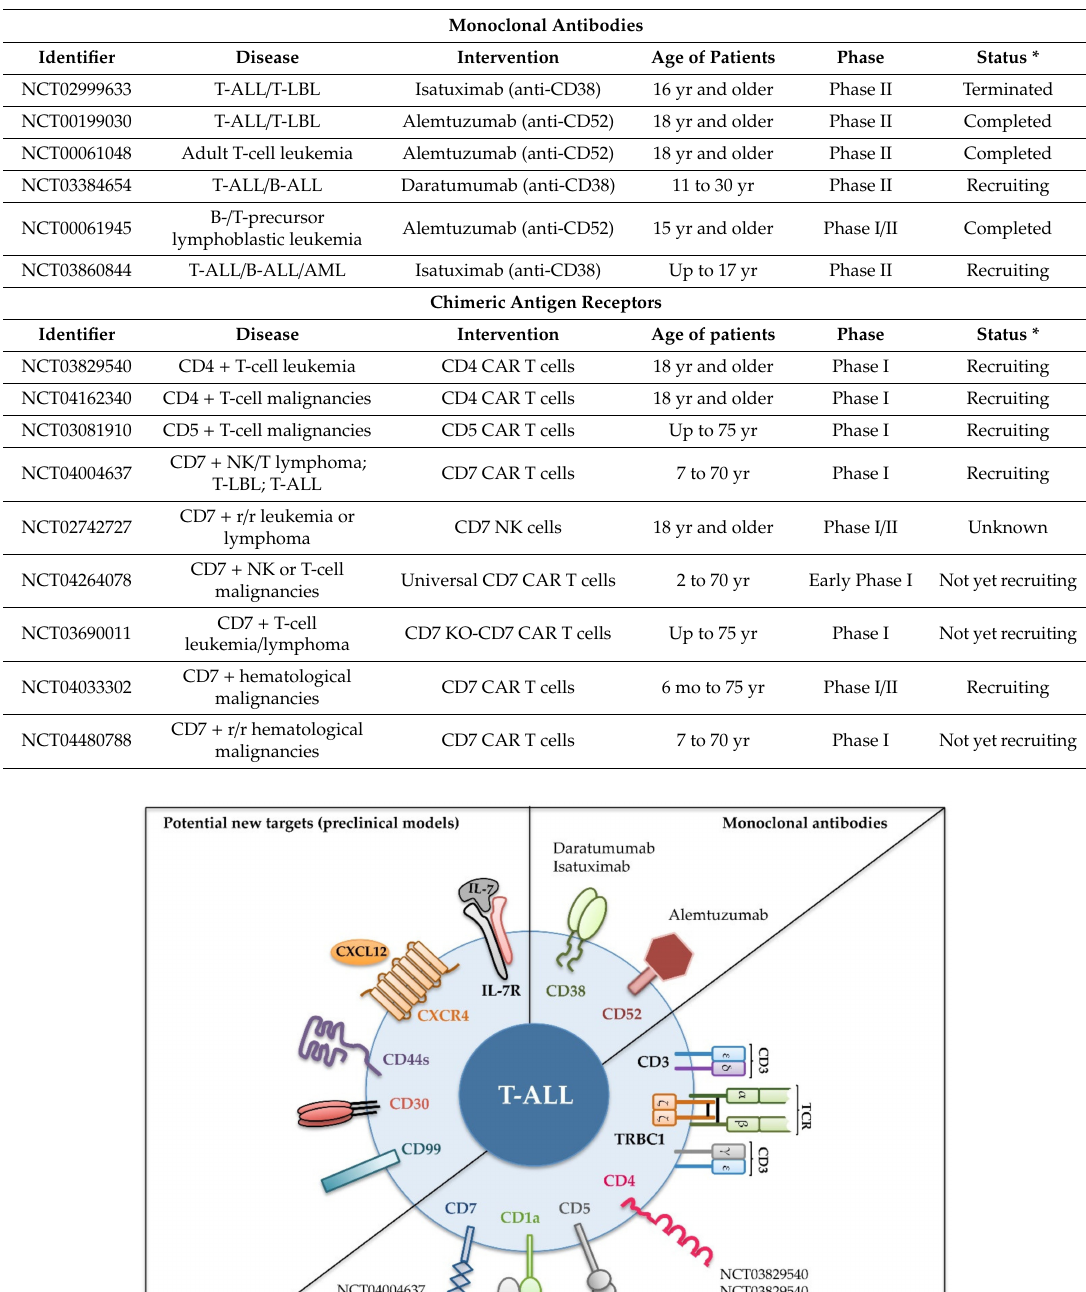
Table 1. Immunotherapy clinical trials [52] based on monoclonal antibodies and chimeric antigen receptors for T-cell malignancies, including T-ALL patients. * as by 28 August 2020.